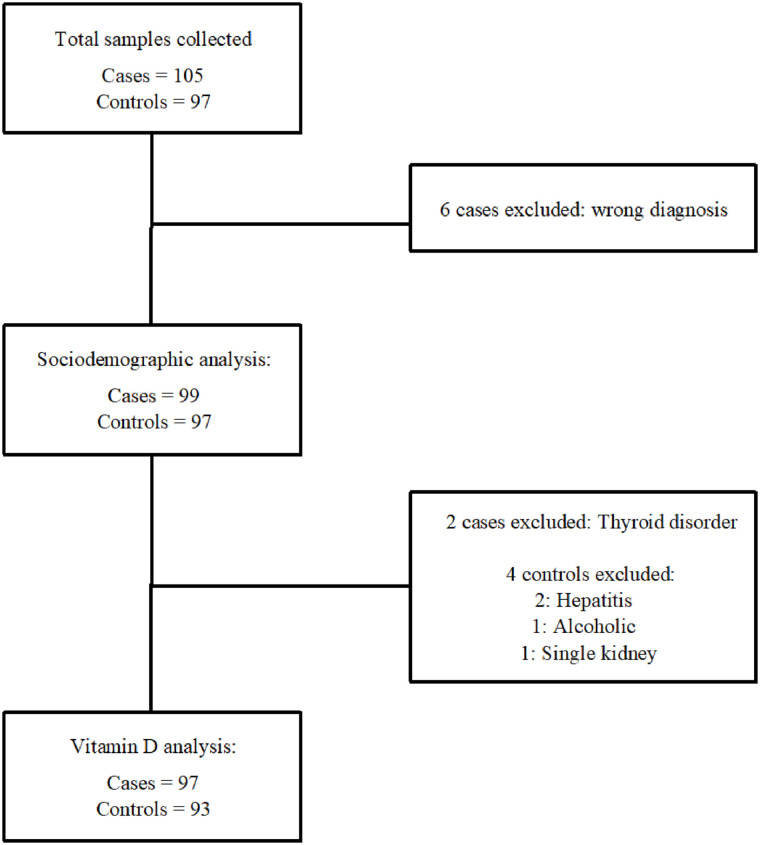
Flowchart of inclusions and exclusions.